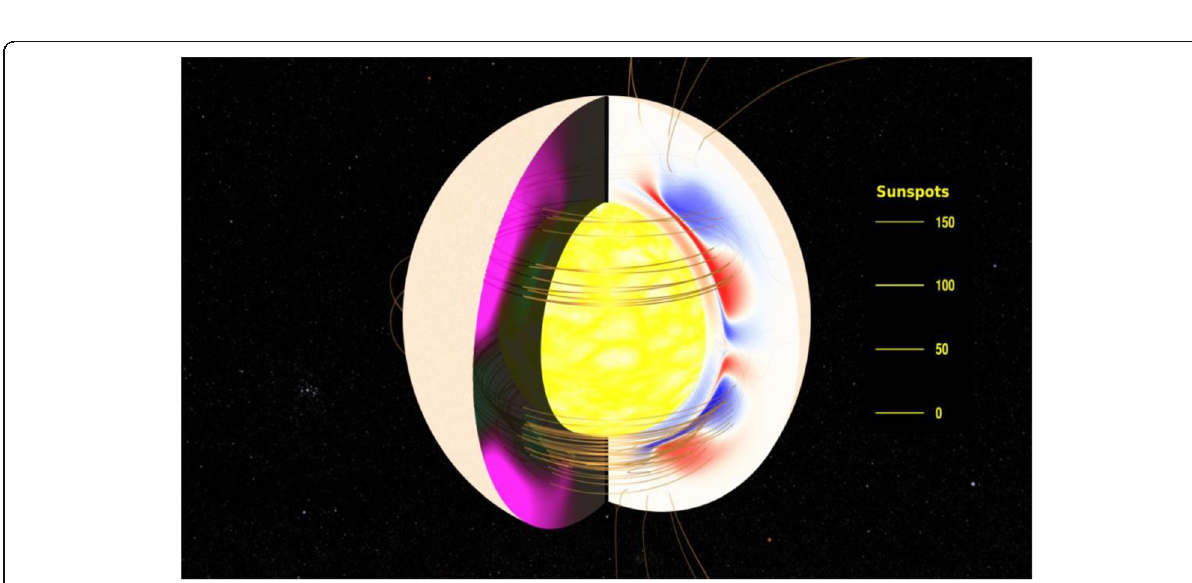
Fig. 3 A rendering of a solar dynamo simulation from Muñoz-Jaramillo et al. (2009) shows the distribution of magnetic fields within the Sun ’ s convection zone at a phase near solar minimum. The left meridional cut depicts the poloidal component (in purple color) and the right meridional cut depicts the toroidal component (red and blue colors indicate opposite polarities). The central yellow region corresponds to the base of the convection zone. On the right, a bar plot denotes the number of sunspots on the solar surface (with yellow lines depicting different values). Since this snapshot corresponds to a solar minimum, there are no sunspots on the surface. The full movie of the simulation can be found at https://svs.gsfc.nasa.gov/3521. Credit: Tom Bridgman, NASA/Goddard Space Flight Center Scientific Visualization